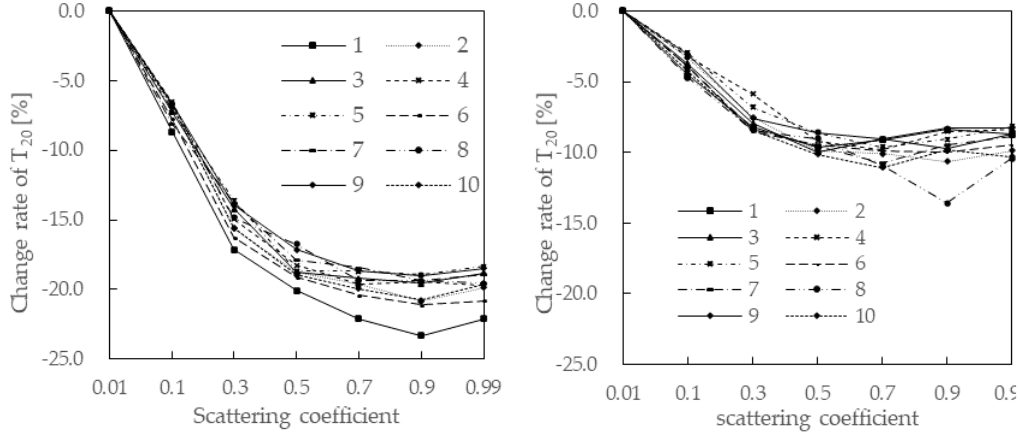
Figure 7. T 20 change rate with scattering coefficient: the same shape but different volumes Note: A—rectangular space, C—both sidewalls tilted. The 1.2–10 are represents amplifications.